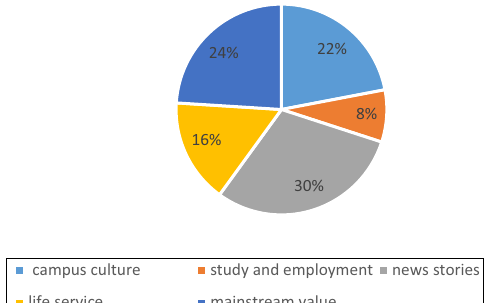
Figure 2. Structure chart of